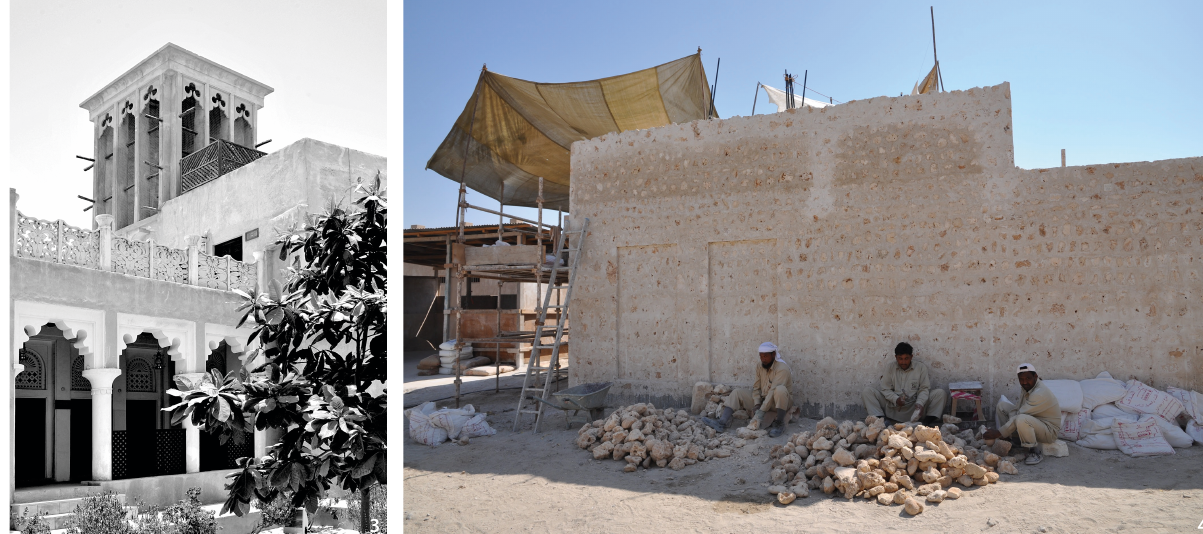
3 Figure 3 Restored Al-Faheidi House, 2013 (Source: F. Cristofoli). Figure 4 Reconstructing the neighbourhood of Shindagha, 2013 (Source: F. Cristofoli).